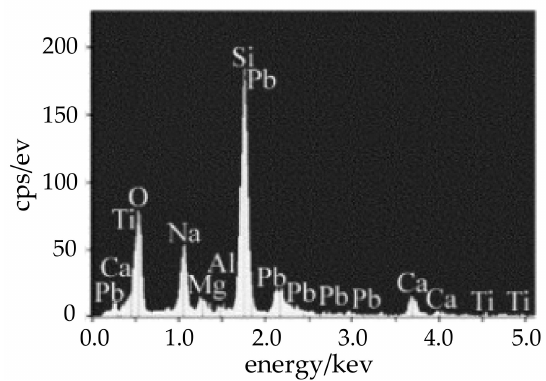
Figure 6. Energy spectrum diagram of P 1 in Figure 2.